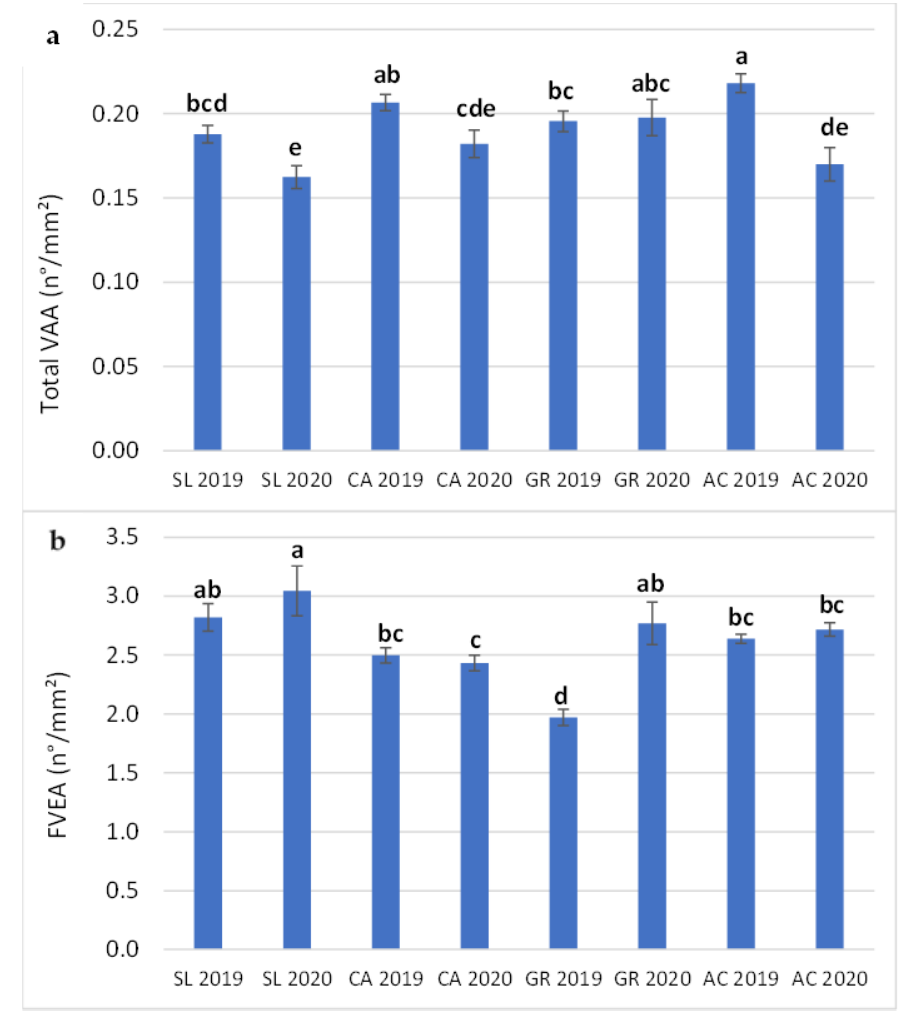
Figure 5. Combined effect of field and year (F x Y) on Total VAA ( a ) and FVEA ( b ) of V. vinifera subsp. vinifera ‘Falanghina’ vines at the four study sites: SL-Santa Lucia, CA-Calvese, GR-Grottole, AC-Acquafredde. Mean values and standard errors are shown. Different letters indicate significant differences according to Duncan’s multiple range test ( p ≤ 0.05).